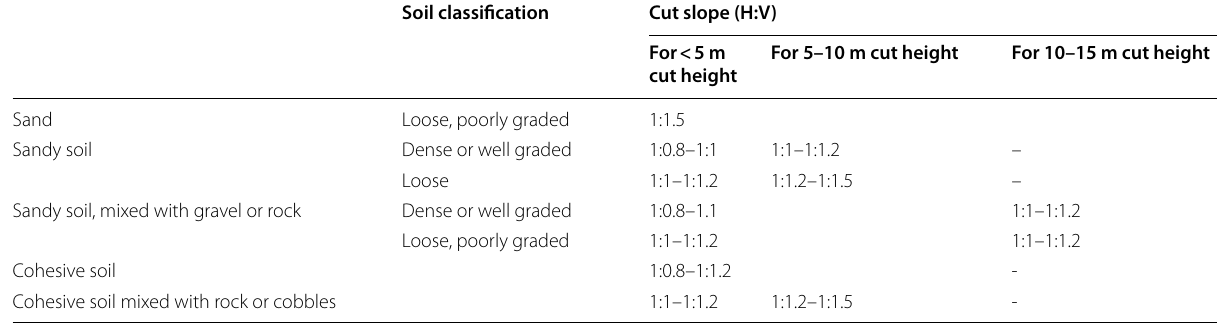
Table 2 Road cut slope excavation guidelines (DoR 2003)